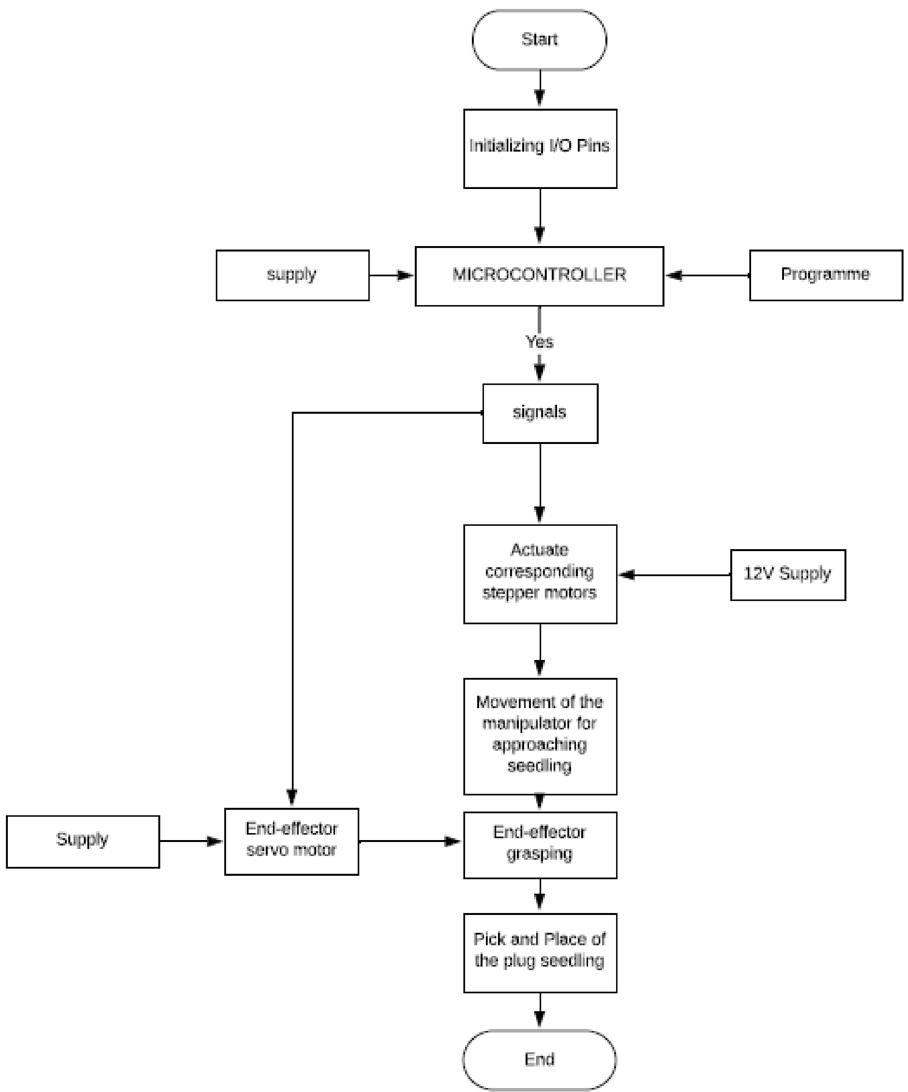
Figure 4. Flow diagram of the seedling picking mechanism used in the robotic transplanter.